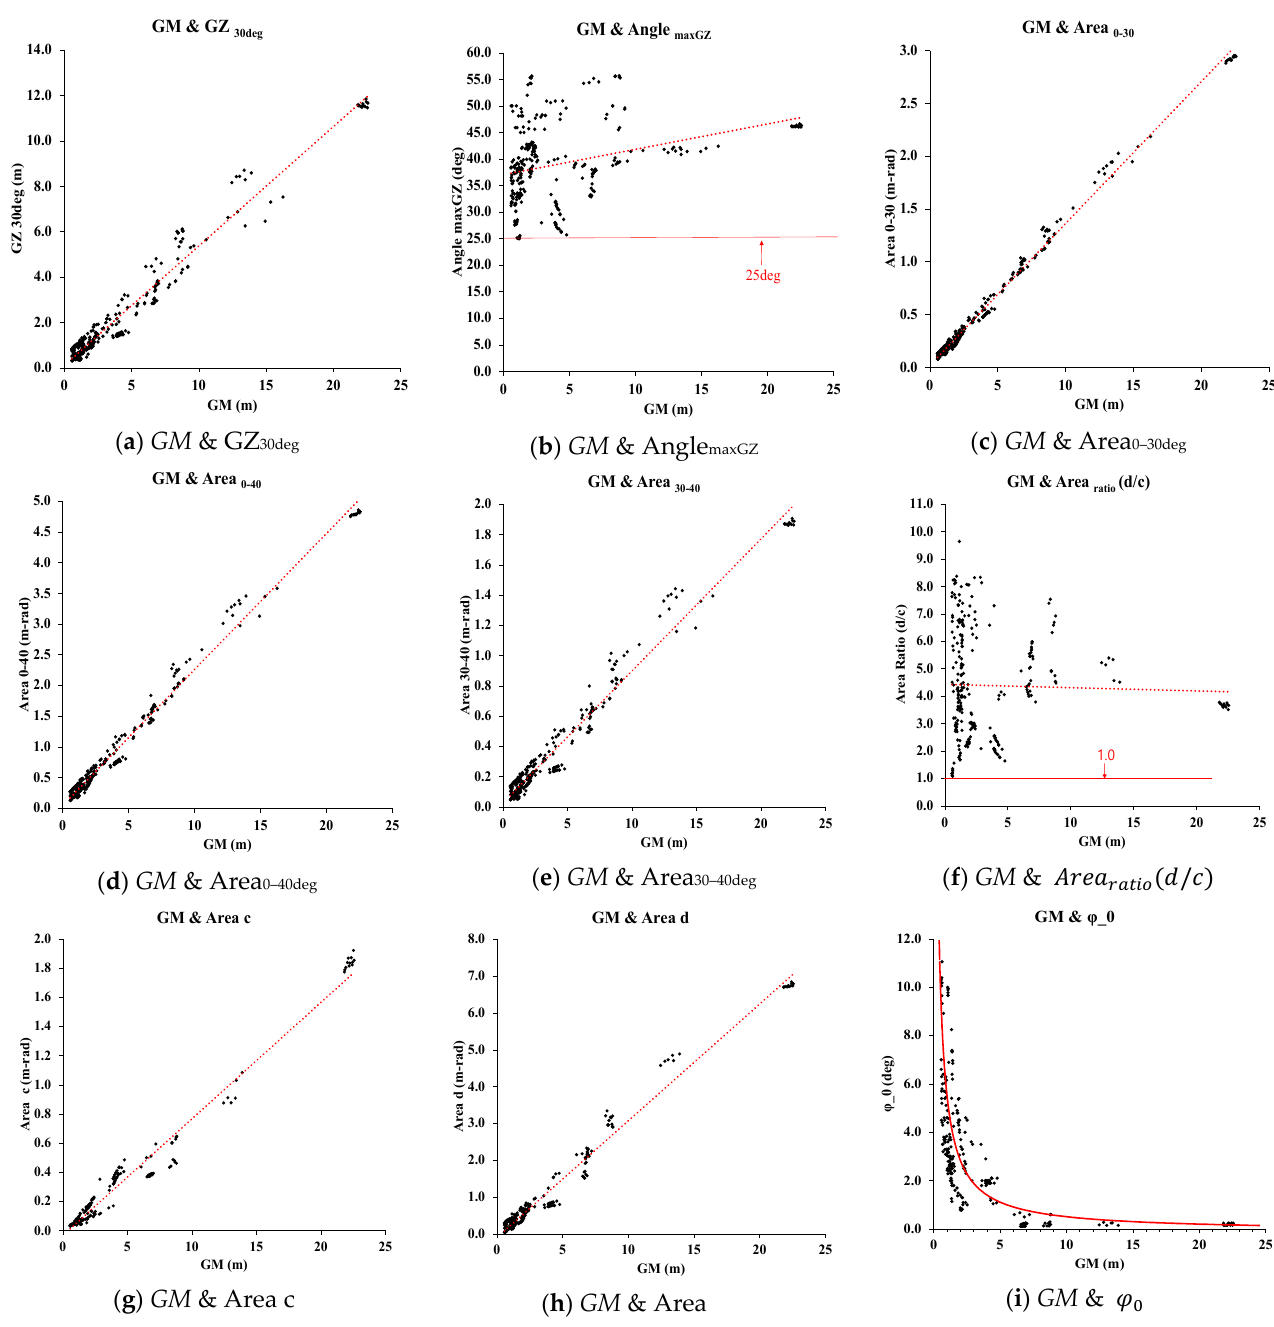
Figure 3. Trend lines of the seven IMO intact stability parameters according to GM . For the fitting procedure of the IMO intact stability parameters according to GM , the linear function using the method of least squares was introduced for eight parameters except for the heeling angle ϕ 0 . The reciprocal function using the method of least